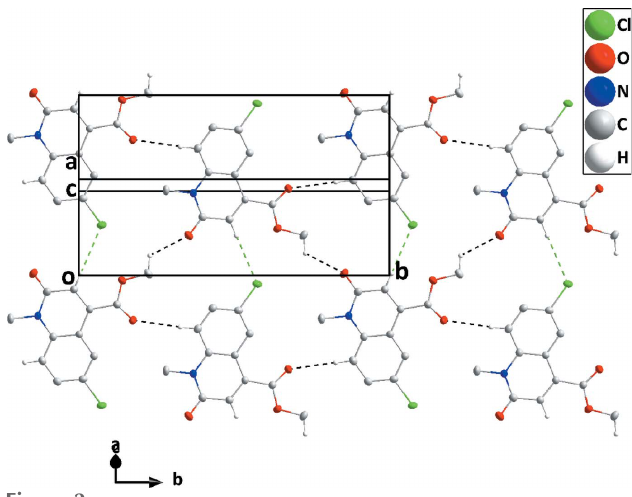
Figure 2 A portion of one layer projected on (101) with C—H (cid:3)(cid:3)(cid:3) O and C—H (cid:3)(cid:3)(cid:3) Cl hydrogen bonds depicted, respectively, by black and green dashed lines.